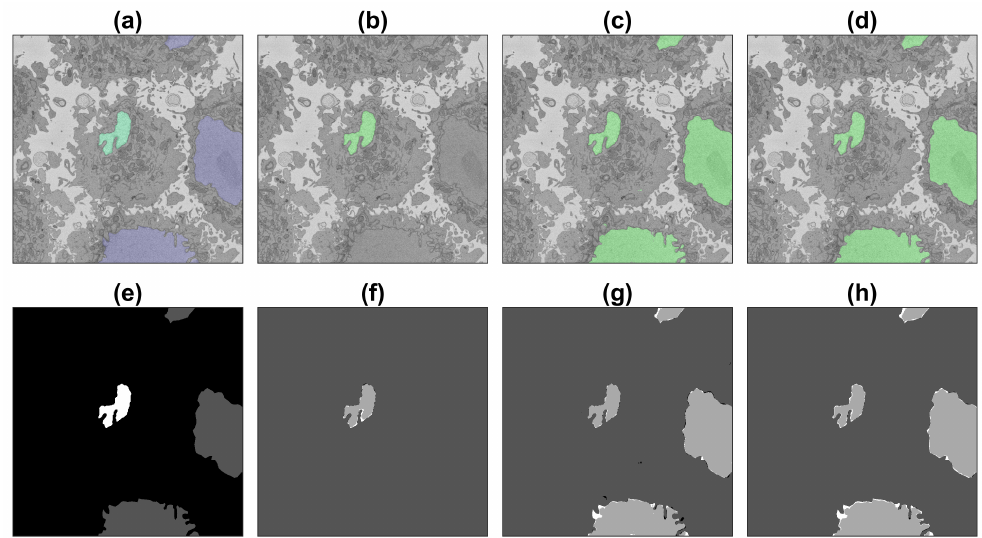
Figure 10. Illustration of the semantic segmentation of one slice (251/300) of the region of interest (ROI) with the image processing (IP) algorithm and U-Net trained with 135,000 patches. For a description, see Figure 8.